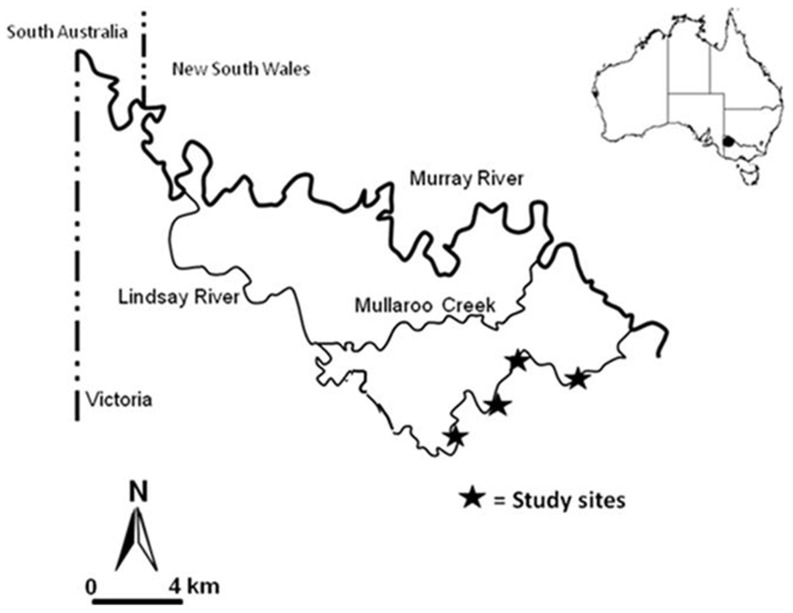
Map of the study area; Lindsay River, Victoria, Australia.